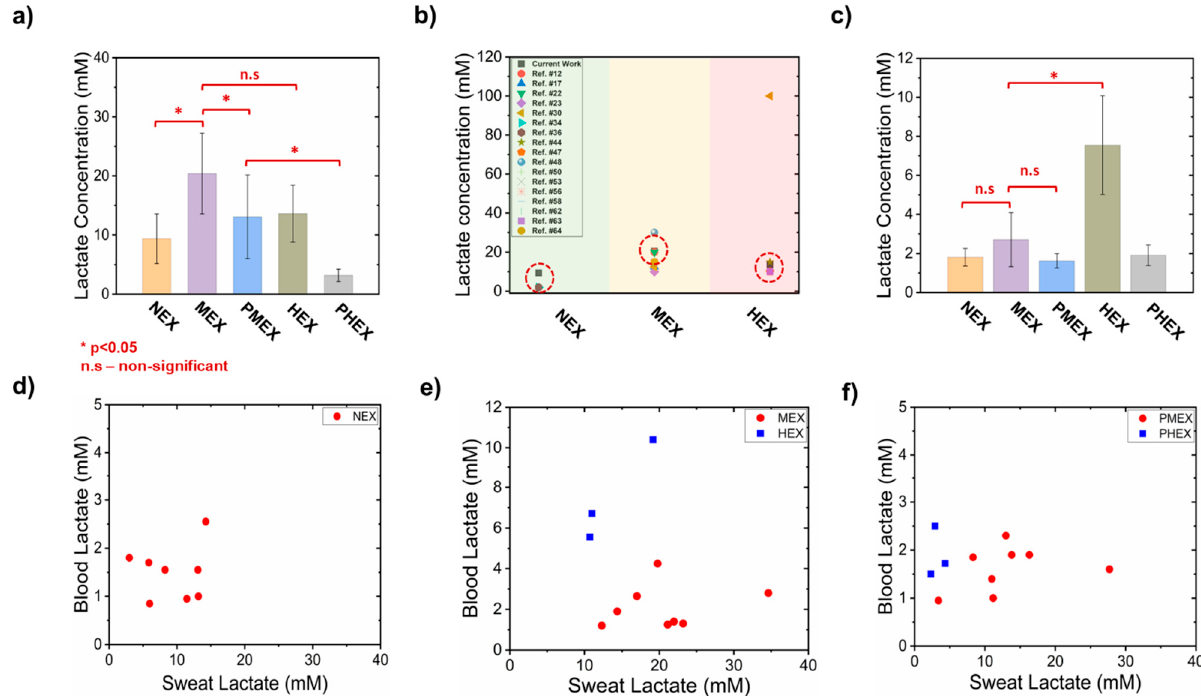
Figure 7. Comparative analysis of sweat lactate concentration readout of 4 M glucose hydrogel patch and blood lactate concentration. ( a ) Plot showing the estimated sweat lactate concentration in a 4 M glucose hydrogel patch under different physiological conditions. ( b ) Plot presenting a comparative analysis of the lactate concentration readout from our patch (dotted circular box) to the lactate concentration data from previously published lactate studies. ( c ) Plot showing the measured blood lactate concentration under different physiological conditions. Relationship of sweat and blood lactate concentration during ( d ) NEX trial, ( e ) MEX and HEX trials, and ( f ) PMEX and PHEX trials. * denotes p <0.05. Each dot denotes data from one subject. These plots elucidate the correlation between blood and sweat lactate levels under different physiological conditions. The error bars denote standard deviation from all subjects.